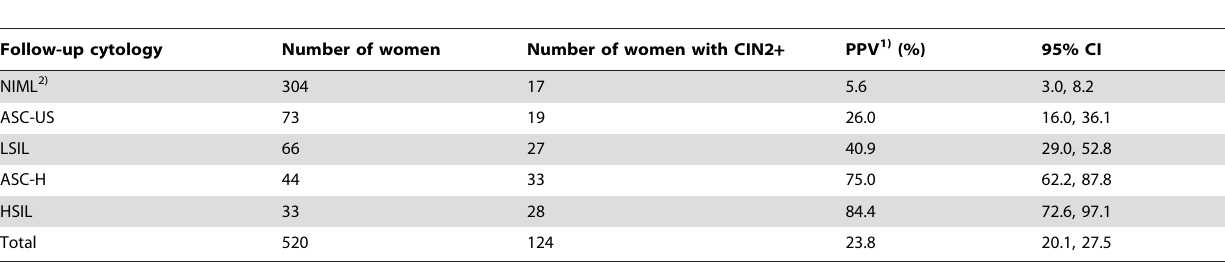
Table 1. Total number of women with negative cervical biopsy and later histologically confirmed CIN2 + by cytological result of post-colposcopy